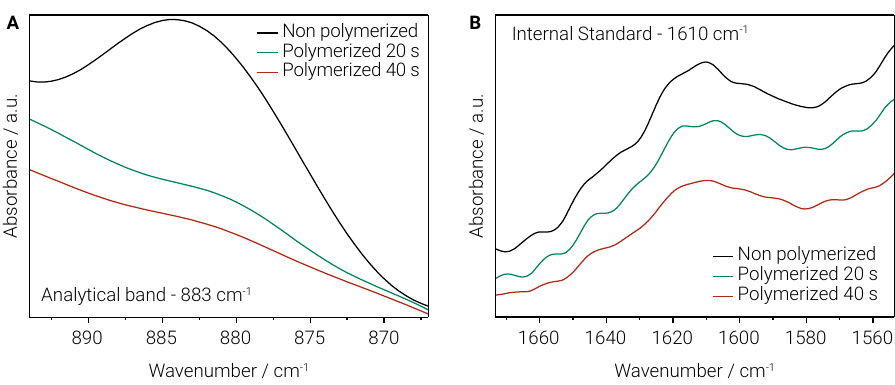
Figure 2. FTIR spectra exhibiting the (A) reduction in peak height at 883 cm -1 associated with the saturation of the oxirane rings within the resin-based oxirane (Filtek P90); (B) absorption of the aromatic C=C stretching band (1610 cm -1 ) remains constant during